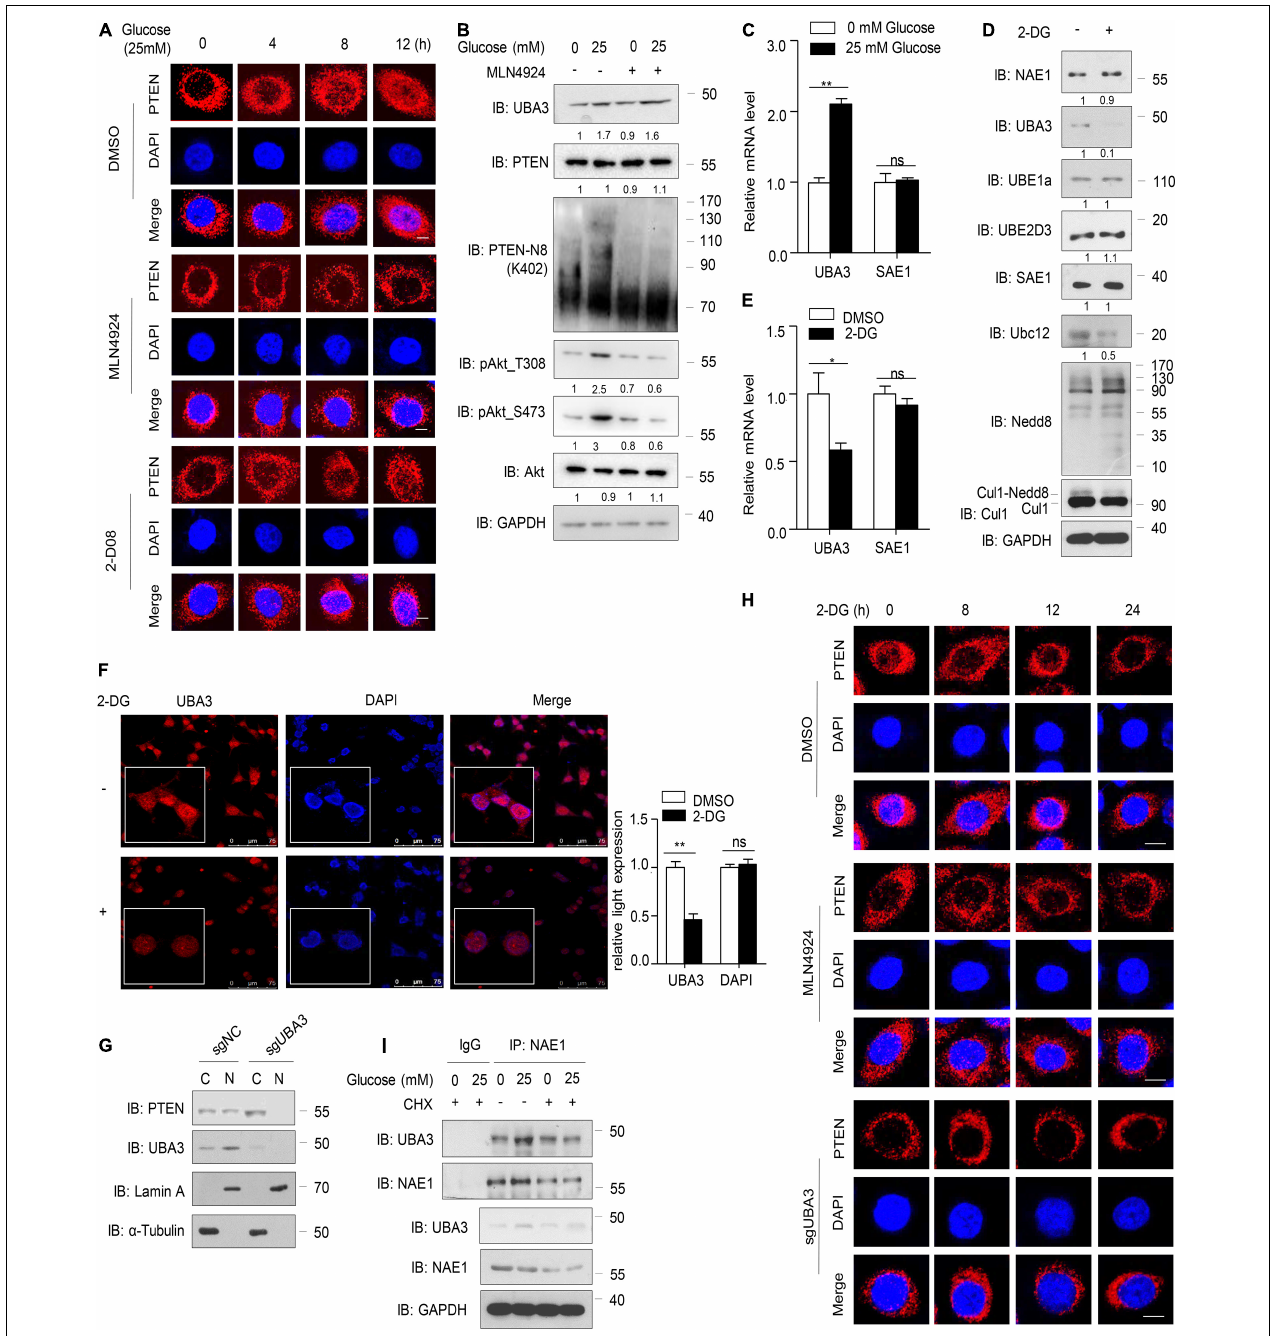
FIGURE 5 | High concentration of glucose increases UBA3 expression. (A) Immunofluorescence of endogenous PTEN in MCF-7 cells. Cells were deprived for glucose for 12 h followed by glucose stimulation (25 mM) for different time. Cells were treated with DMSO, MLN4924 (1 µ M; 12 h) or 2-D08 (5 mM; 24 h) before harvested, respectively. Scale bar, 25 µ m. (B) Immunoblot of WCL from MCF-7 cells cultured in cell medium containing different glucose concentrations. The cells were treated with DMSO or 1 µ M MLN4924 for 12 h. The quantifications of indicated protein contents were analyzed. (C) UBA3 and SAE1 mRNA levels were analyzed by qPCR in MCF-7 cells cultured in different glucose concentrations. * P < 0.05, ** P < 0.01, *** P < 0.001. (D) Immunoblot analysis of WCL from MCF-7 cells. MCF-7 cells were treated without or with 2-DG (5 mM, 24 h) before harvested. The quantifications of indicated protein contents were analyzed. (E) UBA3 and SAE1 mRNA levels were analyzed by qPCR in MCF-7 cells with or without 2-DG (5 mM; 72 h) treatment. Data are shown as the mean ± SD. * P < 0.05, ** P < 0.01, *** P < 0.001. (F) Immunofluorescence of UBA3 in MCF-7 cells with or without 2-DG (5 mM, 24 h) treatment. Scale bar, 75 µ m. The quantifications of indicated protein expression were analyzed. * P < 0.05, ** P < 0.01, *** P < 0.001. (G) Cell fractionation assay of PTEN in UBA3 knockout MCF-7 stable cells. (H) Immunofluorescent assay of PTEN in MCF-7 or UBA3 knockout MCF-7 cells. Cells were deprived for glucose for 12 h followed by glucose stimulation (25 mM) for different time. MCF-7 cells were treated without or with 1 µ M of MLN4924 for 12 h. Scale bar, 25 µ m. (I) Co-IP of interaction between UBA3 and NAE1 in MCF-7 cells. Anti-UBA3 immunoprecipitants were analyzed by western blotting with anti-NAE1 antibodies. Cells were deprived of glucose and followed by glucose stimulation (25 mM). Cells were treated with 100 ng/ml of CHX for 6